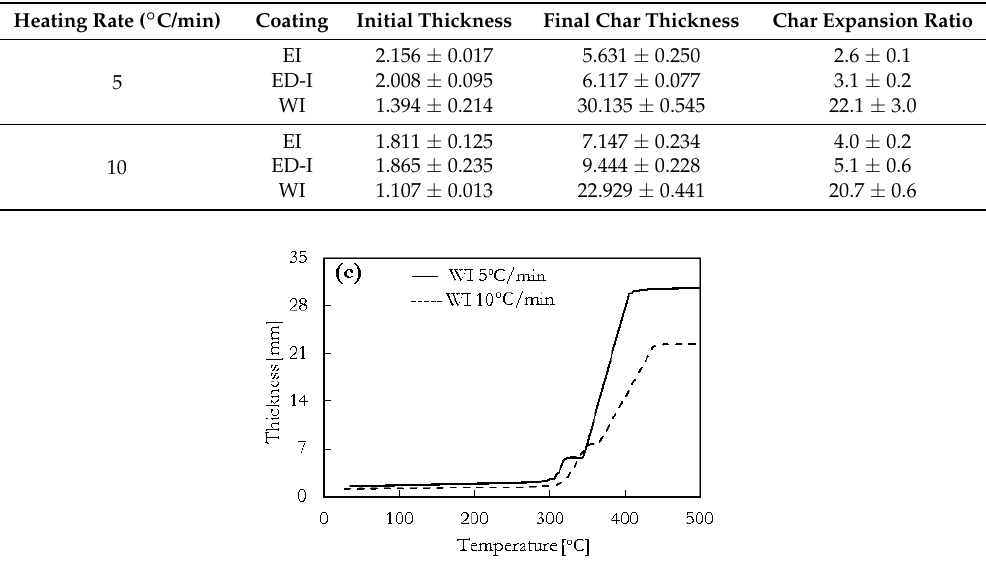
Figure 8. The char thickness vs. temperature curves from rheometer of ( a ) EI, ( b ) ED-I and ( c ) WI coatings at 5 and 10 °C/min heating rate up to 500 °C. (Based on data reported in [16].)